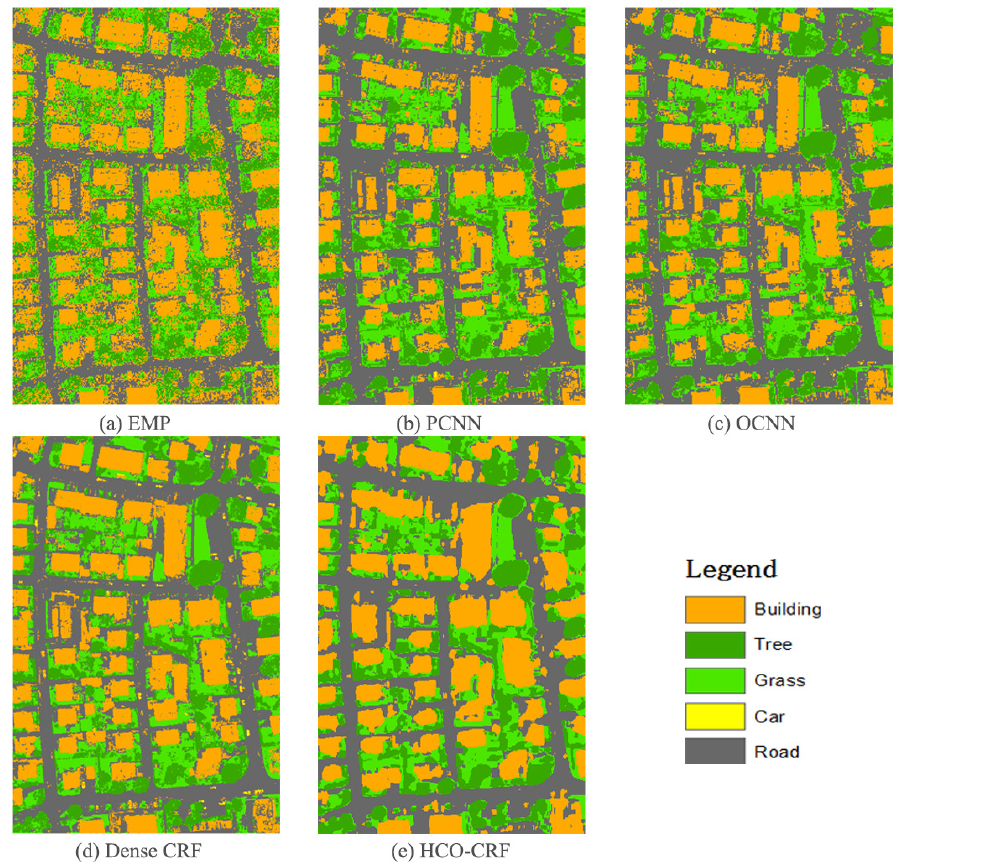
Figure 5. Classification results on Vaihingen dataset with different strategies. ( a ) EMP-based classification; ( b ) pixel-based CNN classification; ( c ) the object-based CNN classification; ( d ) Dense CRF classification; ( e ) HCO-CRF classification